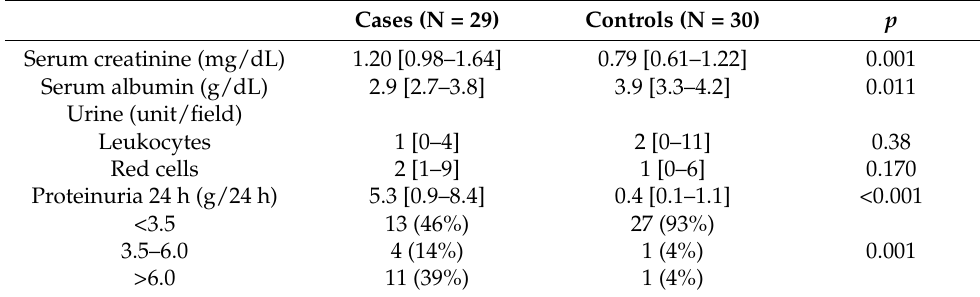
Table 2. Laboratory data in cases and control patients at the time of inclusion in the study. Cases (N = 29) Controls (N = 30) p Serum creatinine